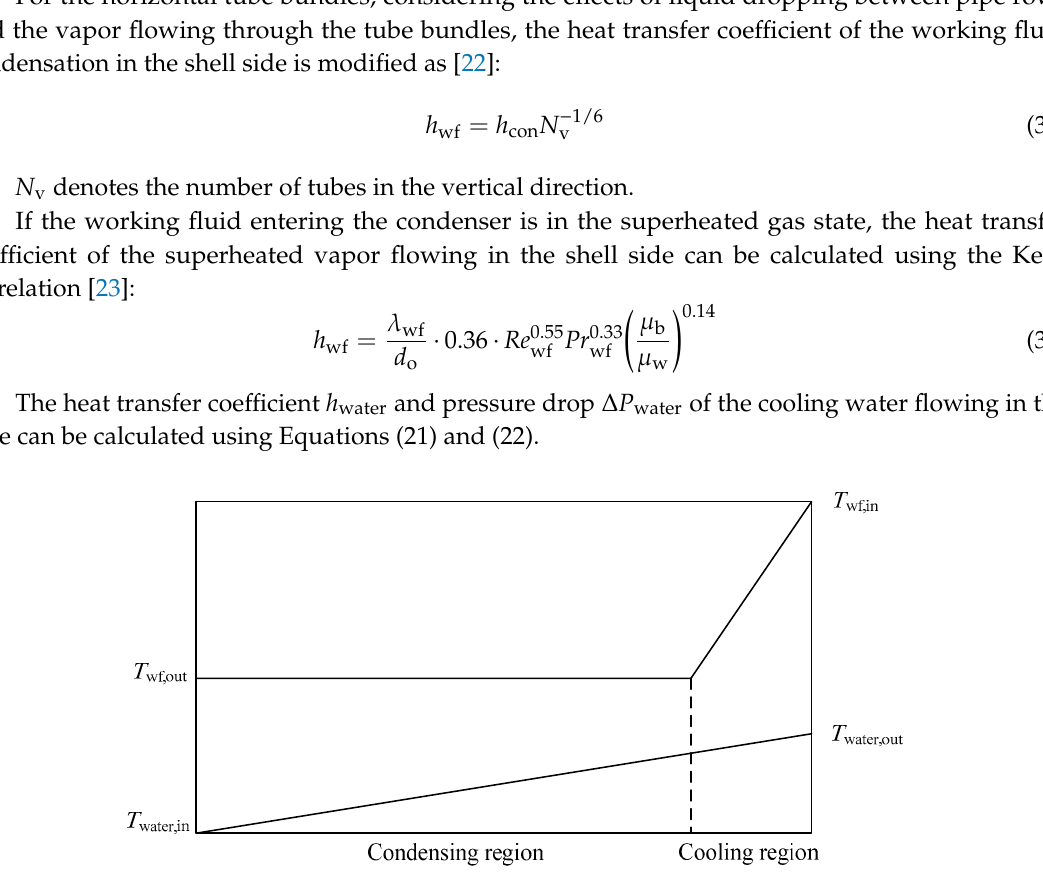
Figure 5. The temperature profile of the condenser.